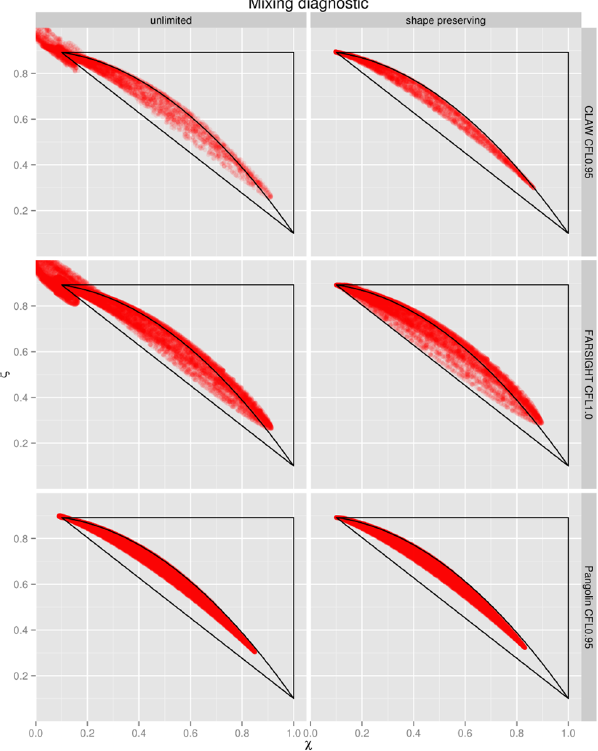
Figure 12. Mixing plots for both unlimited and shape-preserving versions. The resolution is set at 0 . 75 ◦ at the Equator, except for Pangolin, which has 0 . 376 ◦ .